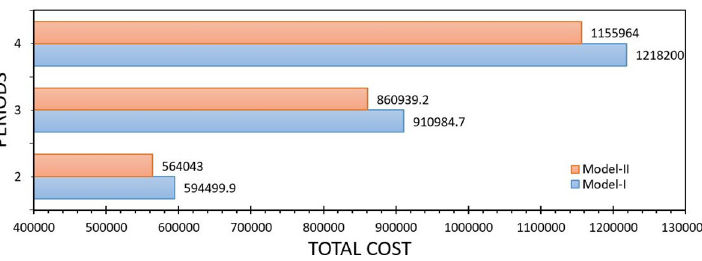
Fig 3. Comparison between Model-I and Model-II with respect to the expected value solution. Own elaboration.